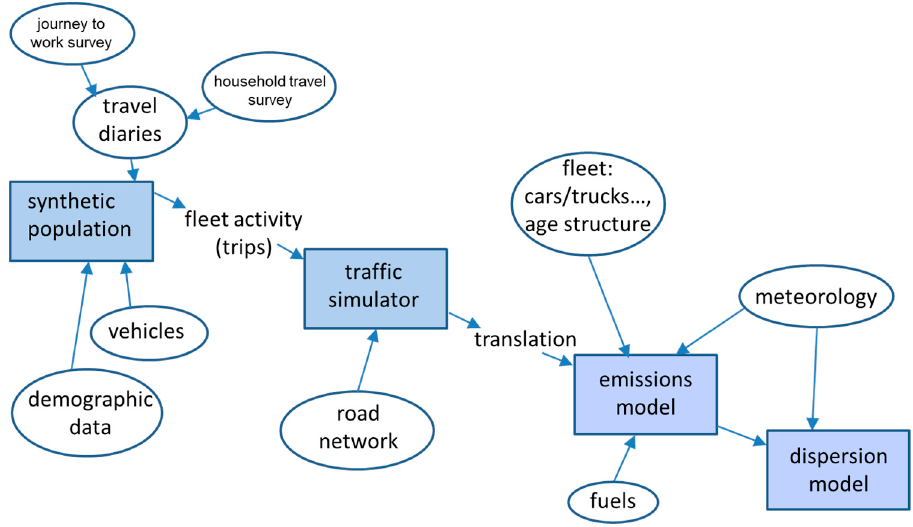
Figure 4. Structure of the traffic emission modelling framework (modified from Forehead and Huynh